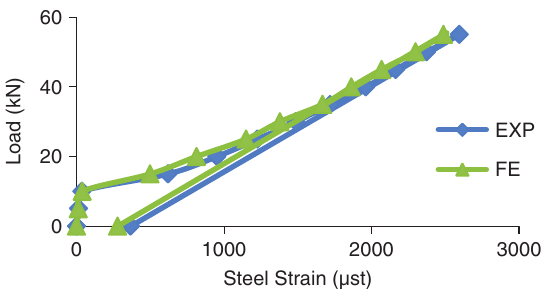
Fig. 19. Load against the cumulative steel strain for the post- repairing phase of the beam